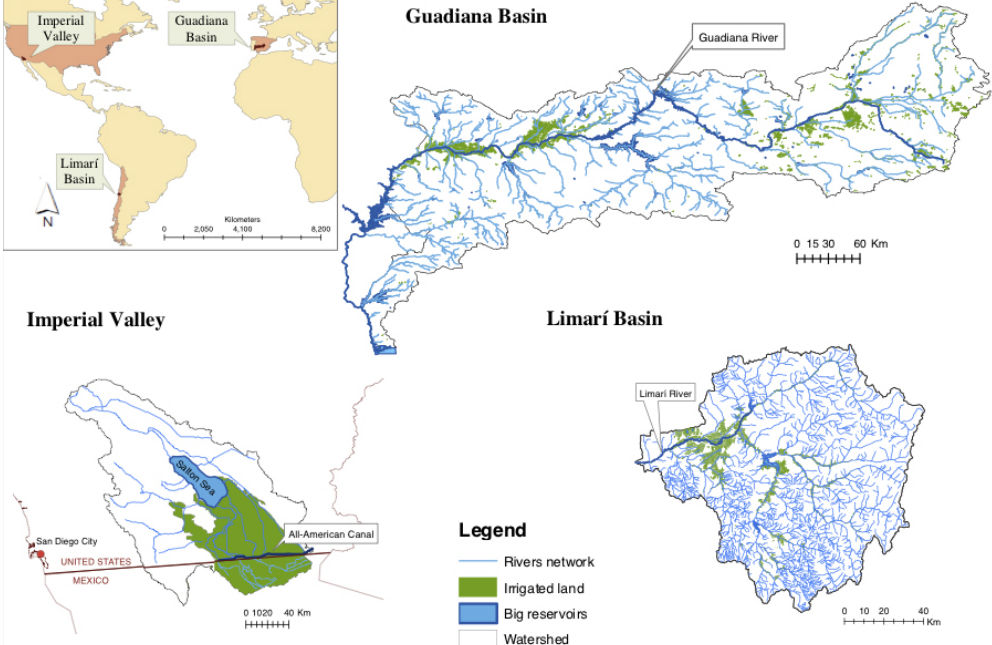
Fig. 2. Basin locator